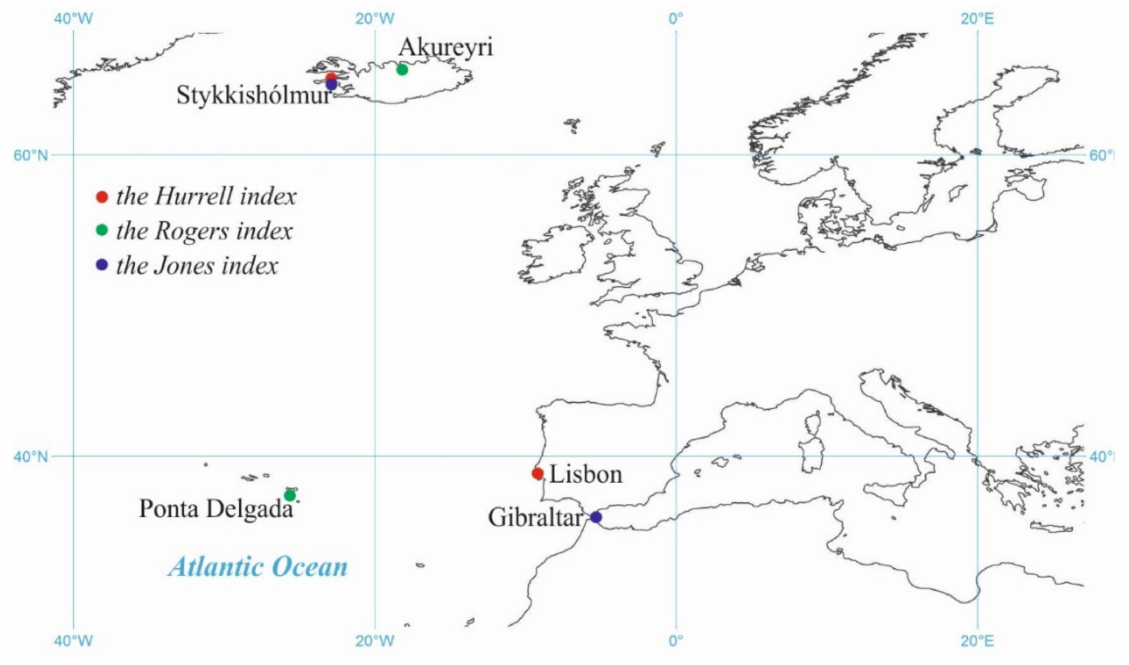
Figure 11. Location of stations for which different NAO indices are